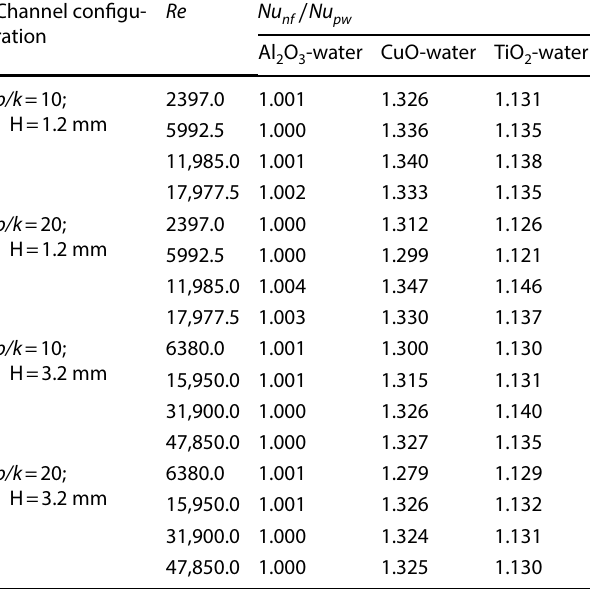
Table 7 Ratios of Nu for the nanofluids and pure water Channel configu-